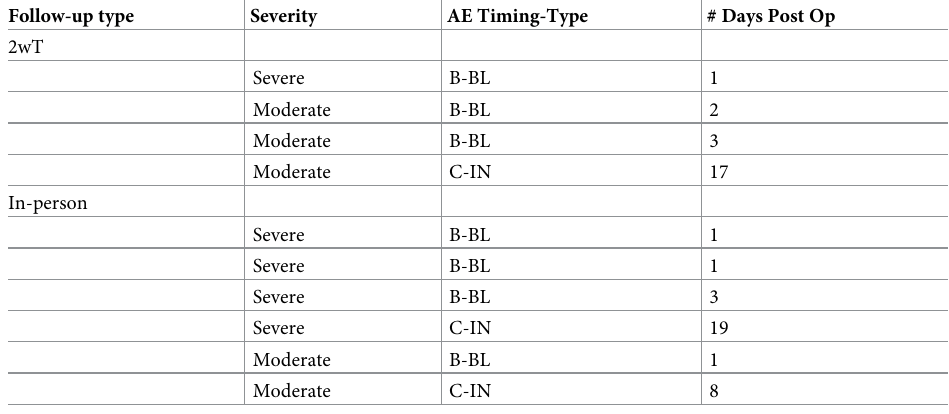
Table 3. Reported AEs among adult patients across ZAZIC sites, January-October 2021. Follow-up type Severity AE Timing-Type # Days Post Op 2wT Severe B-BL 1 Moderate B-BL 2 Moderate B-BL 3 Moderate C-IN 17 In-person Severe B-BL 1 Severe B-BL 1 Severe B-BL 3 Severe C-IN 19 Moderate B-BL 1 Moderate C-IN 8 Timing of AEs: A = Intra-operative or immediately postoperative (prior to discharge from clinic); B = After discharge and up to 7 days post-operative; C = Greater than 7 days post-operative. AE types: BL = Bleeding; IN =